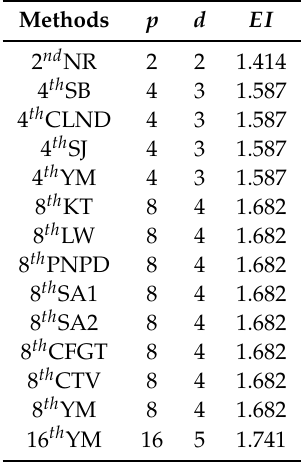
Table 1. Comparison of Efficiency